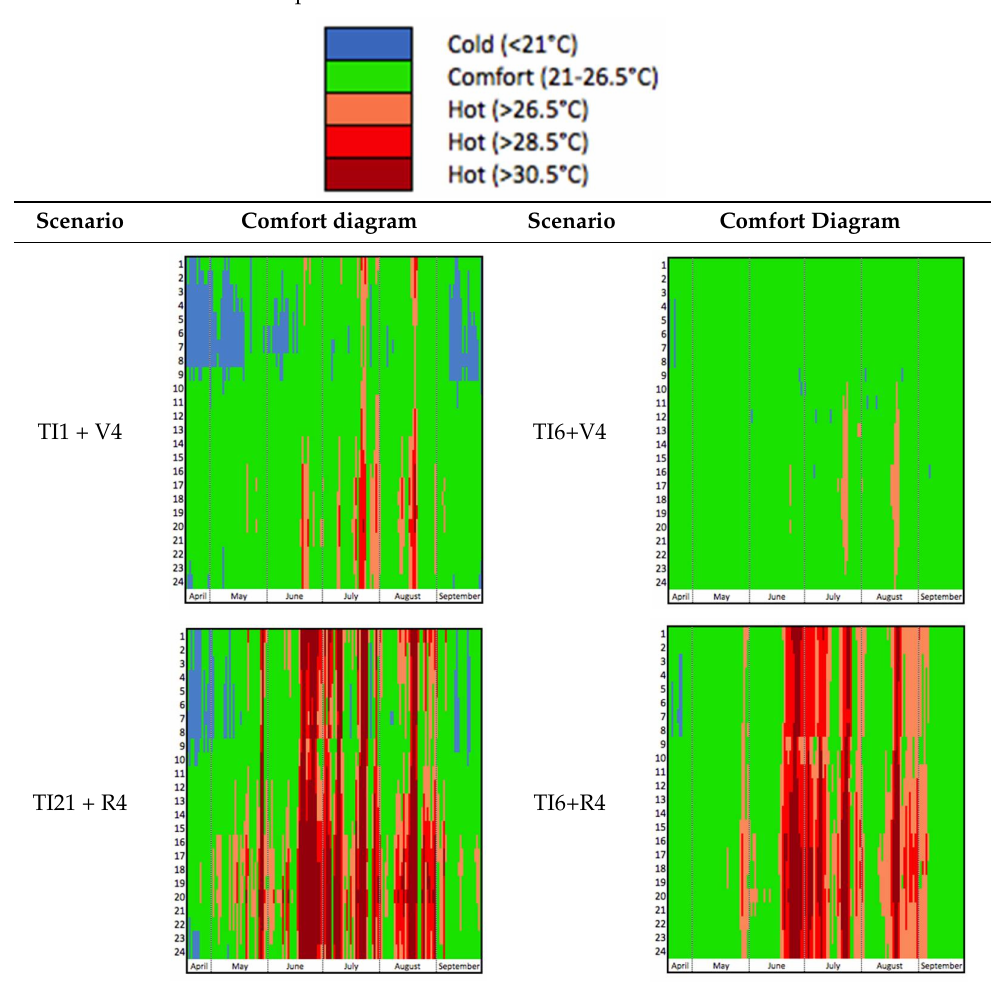
Table 8. Temperature distribution over the summer for